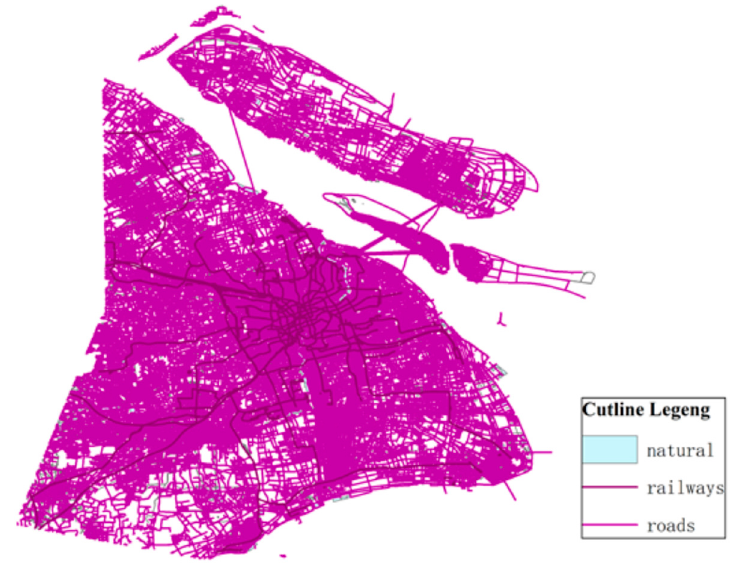
Figure 5. Road function image recognition.